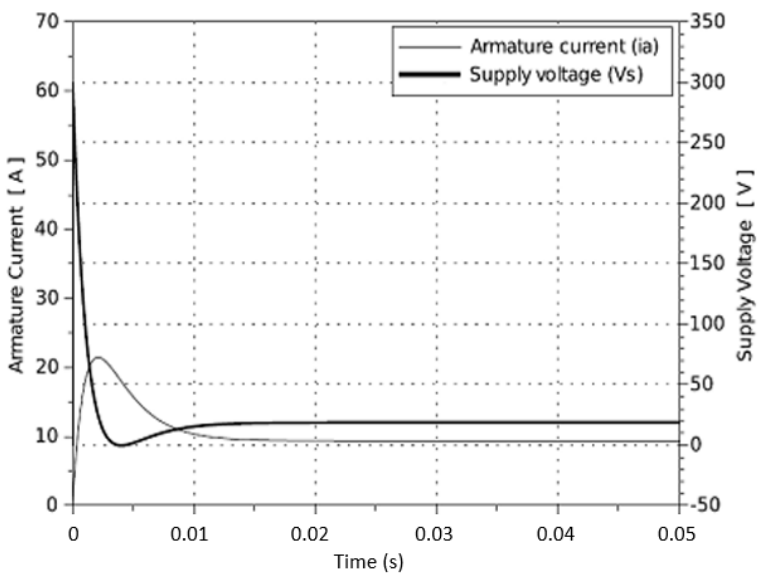
Figure 18. Armature current and supplied voltage in no-load conditions with a speed controller using K P = 3, K D = 0.01, and ω D = 100 rad/s.